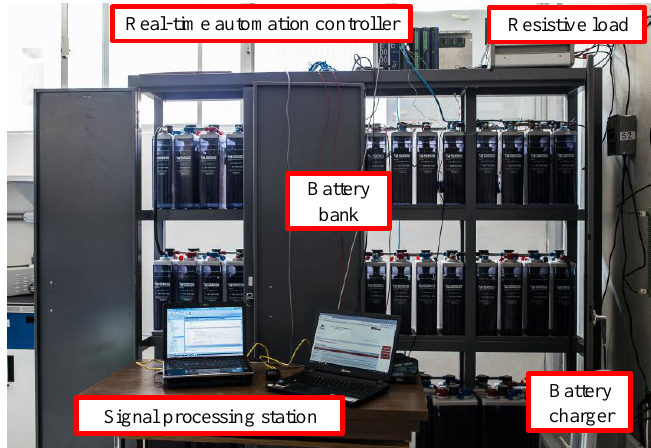
Figure 2. Test bench implemented to emulate the conditions of an electrical substation.